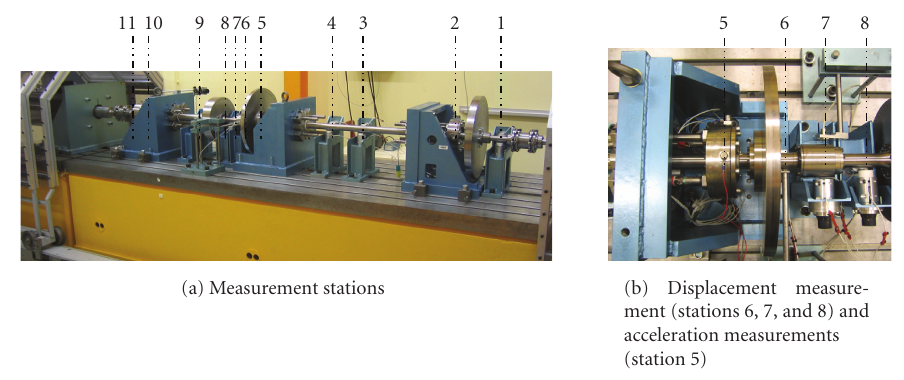
Figure 3: Static support compliance tests.